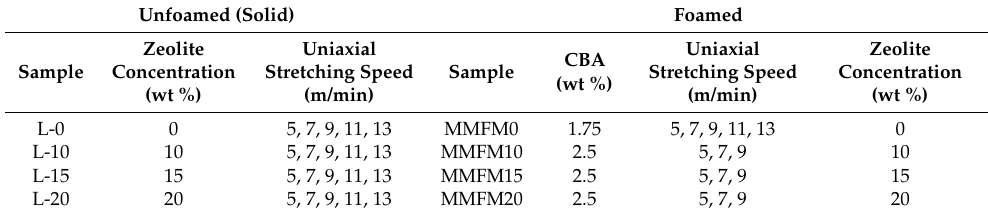
Figure 1. Schematic representation of the extrusion set-up to produce hollow fiber mixed matrix foamed membranes. Table 1. Specifications of the hollow fibers produced *.